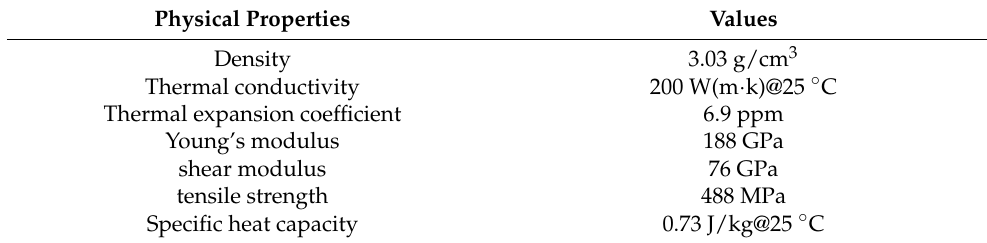
Table 2. Physical properties of the 65%vol. SiCp/Al [36–38].